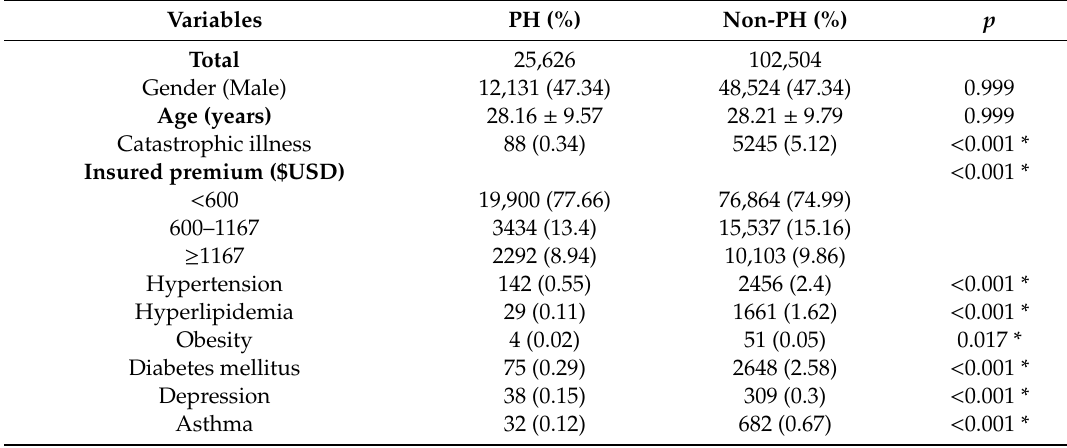
Table 1. The characteristics of the palmar hyperhidrosis and control groups.